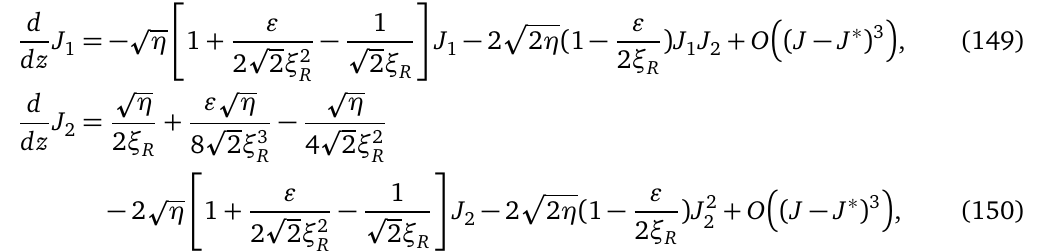
Figure 4: The double-trace coupling J at the stable (blue line) and unstable (orange 2 line) fixed point as a function of w at b = 0.2 (a); as a function of b at w = − 0.5 (b ), w = − 0.2 (b ), w = − 0.05 (b ), w = − 0.01 (b ). Three RG flow diagrams at 1 2 3 4 w = − 0.5 and b = 0.0001 (c ), b = 0.001 (c ), b = 0.1 (c ), b = 0.5 (Fig. 1) are 1 2 3 also presented. a = − 0.1 is used for all